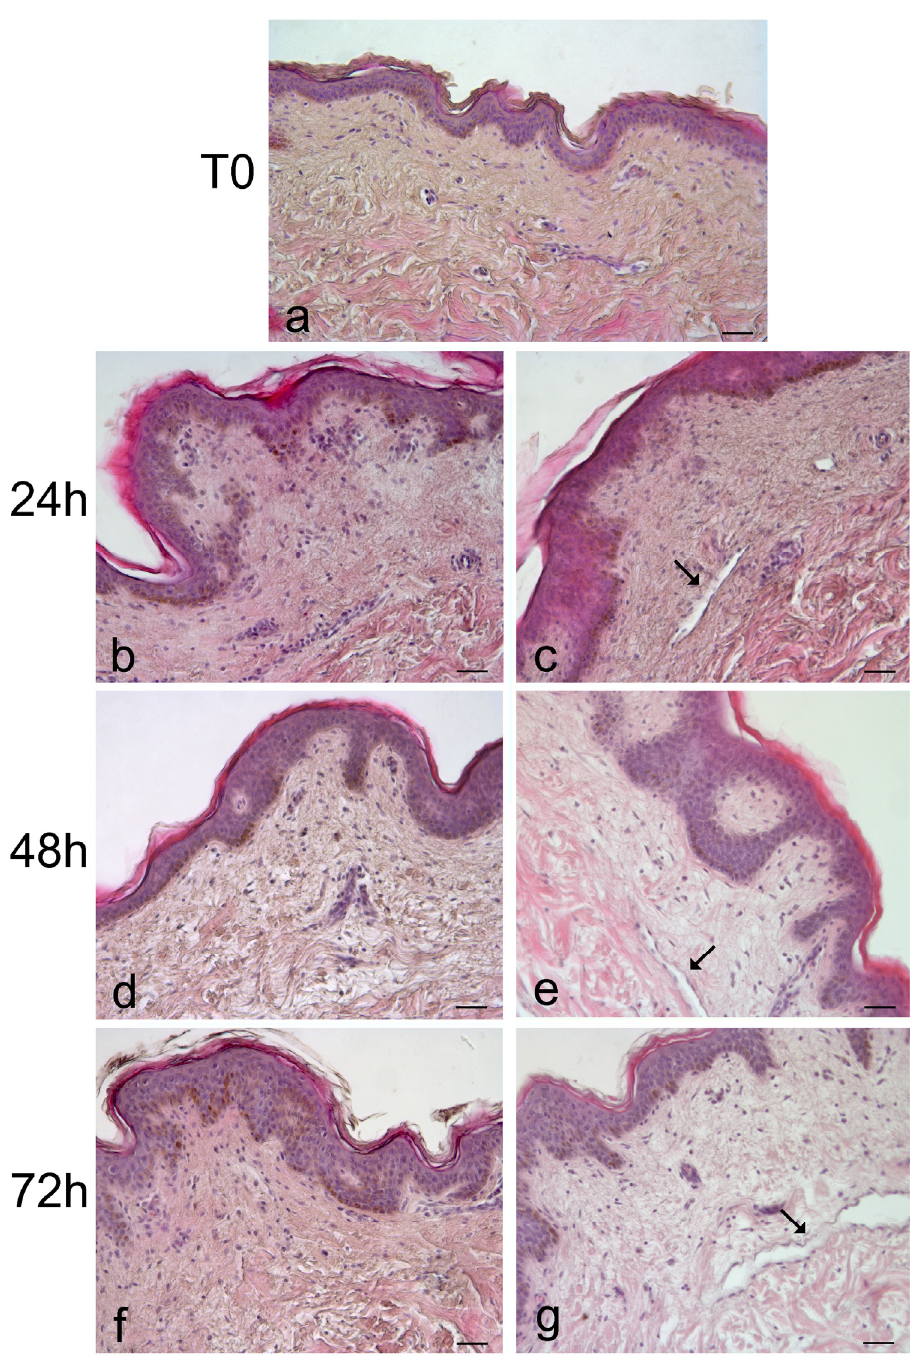
Figure 10. Bright- fi eld microscopy images of human skin samples at T0 ( a ) and after 24 h ( b , c ), 48 h ( d , e ) and 72 h ( f , g ) in the bioreactor in the presence of substance P ( c , e , g ) or without substance P as controls ( b , d , f ). Note the dilated capillaries in ( c , e , g ) (arrows). Bars: 50 µm.